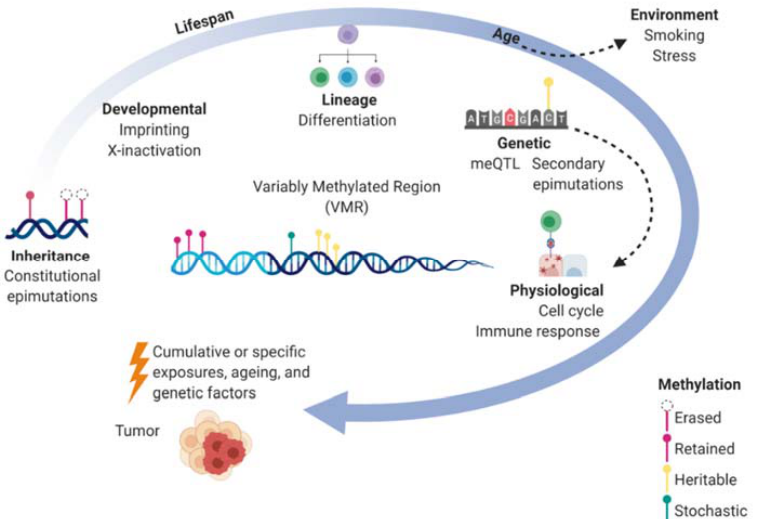
Figure 1. Dynamics of the methylome over the lifespan and the contribution to cancer. Within a variably methylated region (VMR) for a particular cell, the methylome can be shaped by molecular factors (inside circle) such as inherited methylation marks, developmental processes, cellular differ- entiation, genetic sequence, and physiological states which are shown to be dependent on genetics as well. Environmental factors also effect methylation where epimutations not only accumulate over time but have larger effects on methylation with ageing. The cumulative effects of genetic, epigenetic, and environmental exposures contribute to the development of